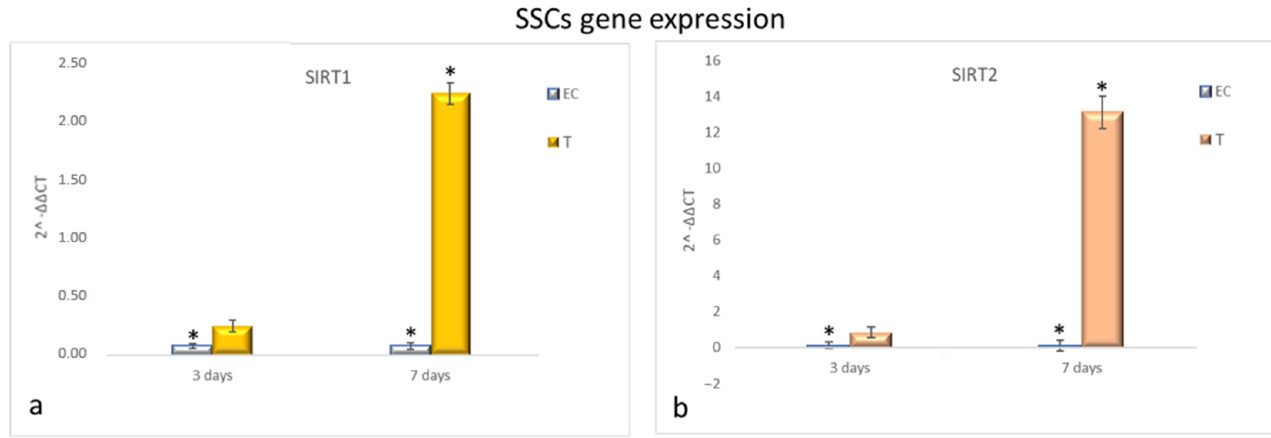
Figure 4. Gene expression analysis of SIRT1 and SIRT2 in HFF1 ( a , b ). HFF1 was exposed to the different culturing condi- tions. mRNA levels of SIRT1 ( a ) and SIRT2 ( b ) in EC (grey bars) and T (colored bars) are expressed as fold change (2 −∆∆ ct ) compared with negative controls (UnC = 1). EC and T cells were exposed to UV light for 2 min at 10 cm distance from the lamp to induce oxidative stress. UnC samples were not exposed to UV light and not pre-treated with NanoPCL-M (UnC = 1), T samples were pre-treated with NanoPCL-M before UV stress exposure. * p ≤ 0.05.